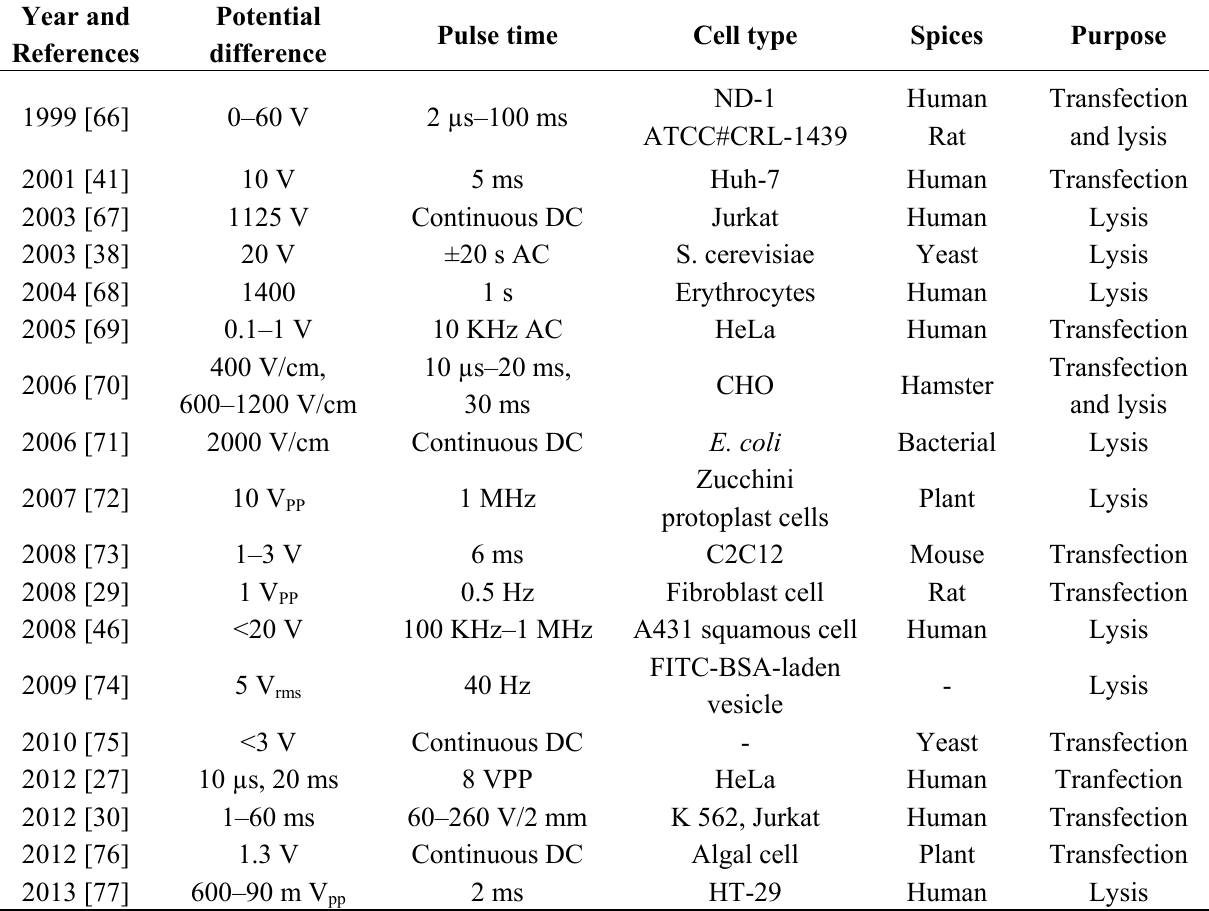
Table 1. Performance of Micro/nanofludic single cell